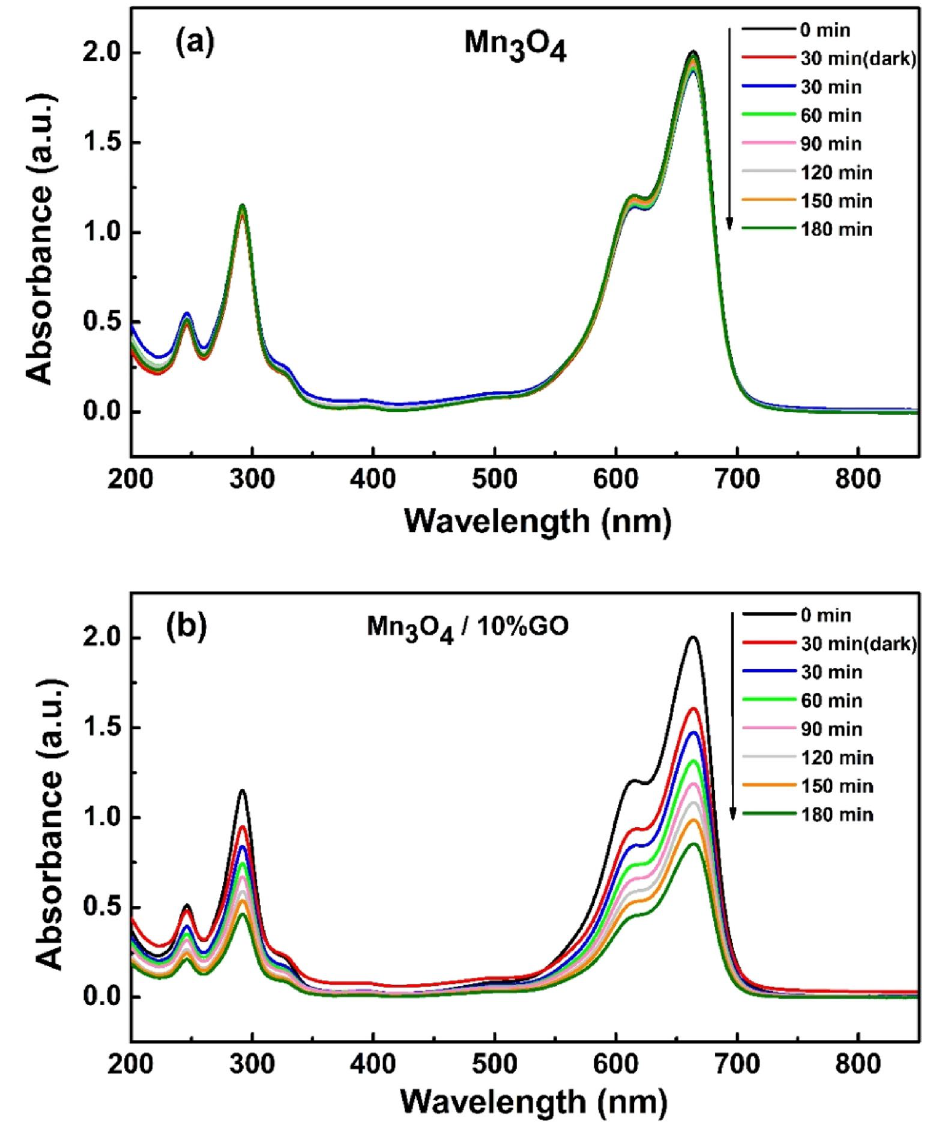
Fig. 10 Absorption spectra of the MB solutions contain- ing: a Mn O NP’s and b 3 4 Mn O /10%GO NC’s after they 3 4 were exposed to the laser radiation for different amounts of